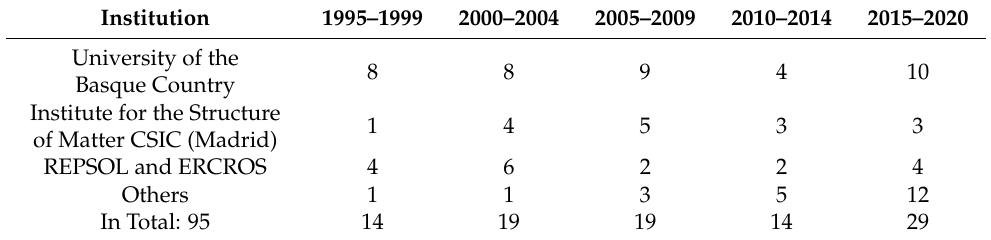
Table 2. Distribution of the papers published about rheology of thermoplastics processing in the period